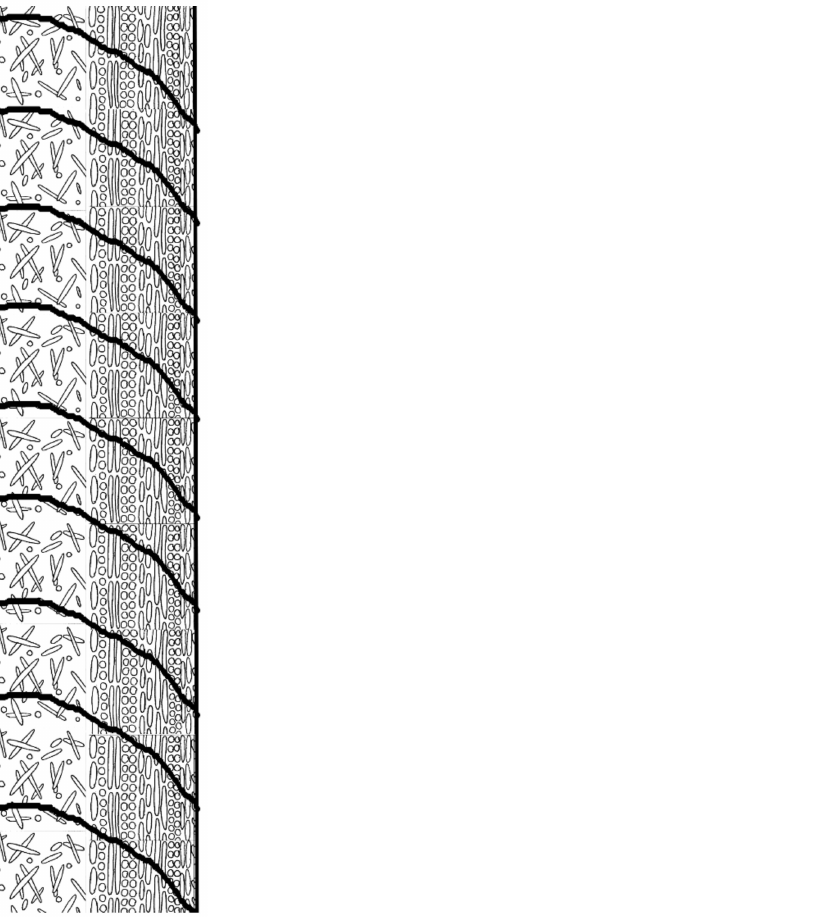
Figure 9. Tube structure of Hydroides dianthus . The same growth increment goes across three different